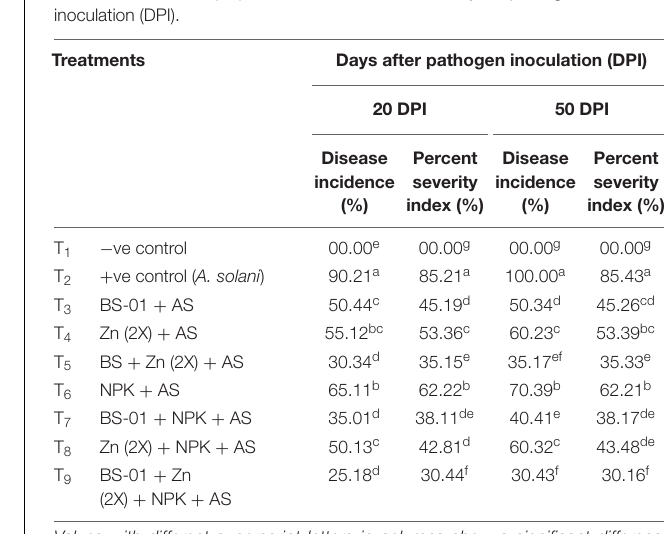
(p ≤ 0.05) in the mean value of replicates as determined by the LSD